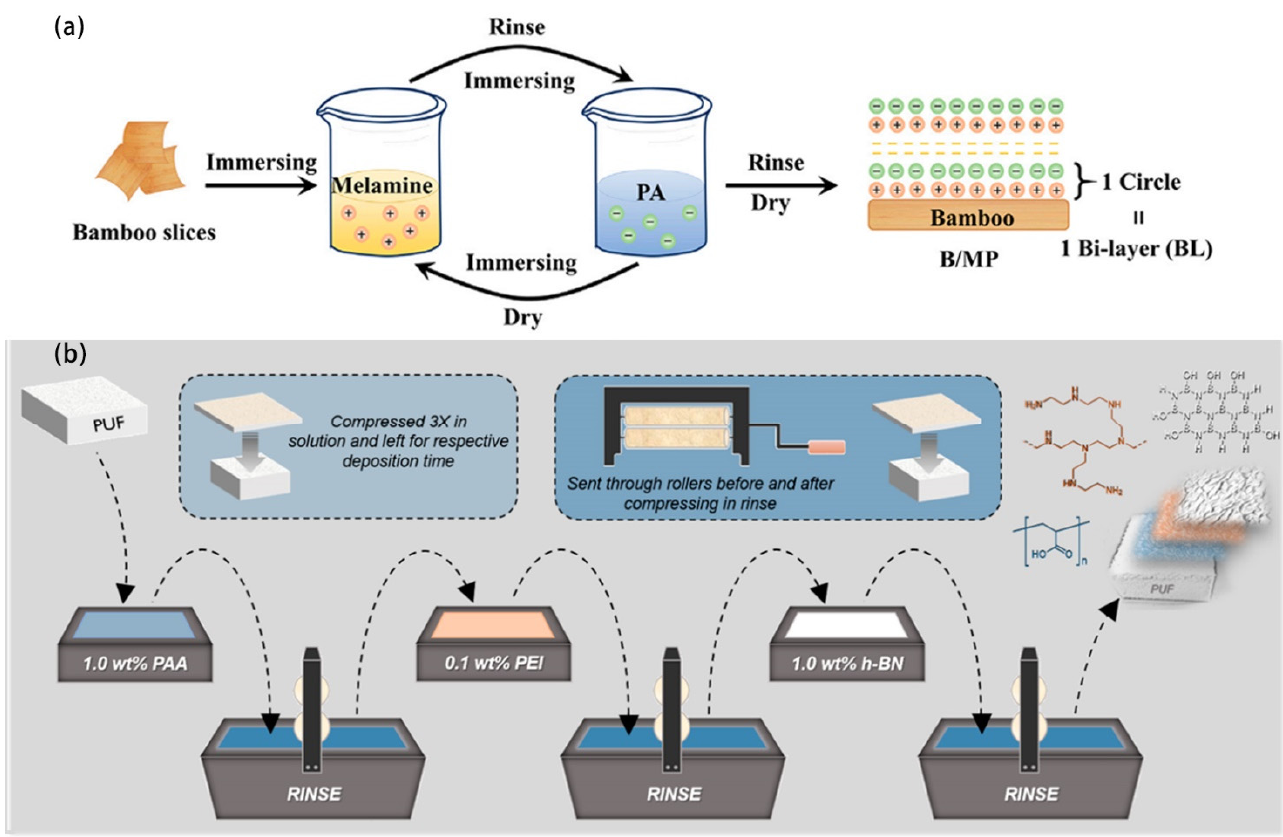
Figure 7. The preparation process of a flame-retardant coating through layer-by-layer assembly by ( a ) dipping method: coating melamine (M) and phytate (P) onto bamboo (B)); reprinted from Ref. [103] and ( b ) spraying method: coating hexagonal boron nitride (h-BN) and polyethylenimine (PEI) onto poly(acrylic acid) (PAA) modified polyurethane foam (PUF)). Reprinted with permission from Ref. [61] Copyright 2019 American Chemical Society.